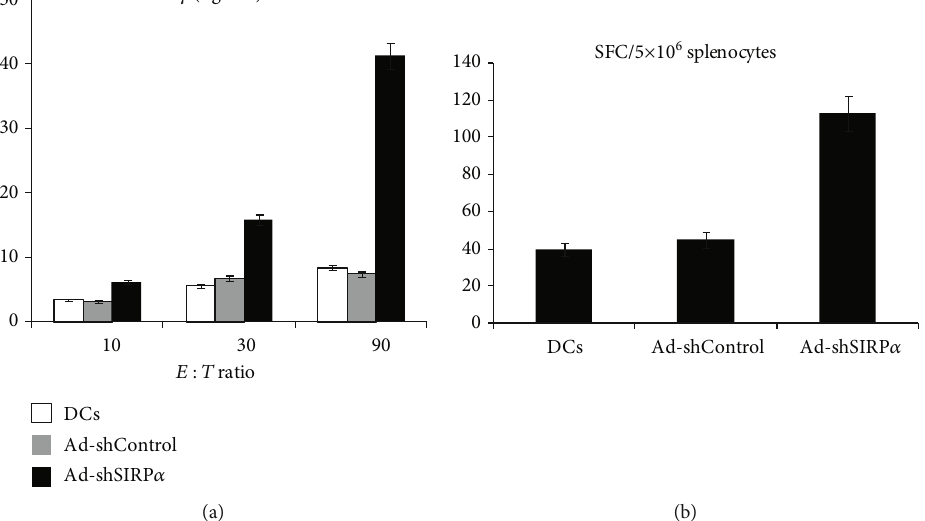
Figure 4: ELISA and ELISPOT analysis of IFN- γ . The IFN- γ secretion levels of the DCs induced and TC-1 cell-stimulated splenocytes at 90: 1, 30 :1, and 10 :1 E : T ratios were determined by ELISA. The plate was processed according to the manufacturer ’ s protocol, and the wells were photographed using a micropublisher camera on a stereo microscope. The dots were counted manually using an ImageJ cell counter. The frequencies of the activated antigen-speci fi c cytotoxic T cells in splenocytes harvested from immunized C57BL/6 mice ( n = 3 ) were evaluated via ELISPOT. p < 0 : 01 (Ad-shSIRP α vs.